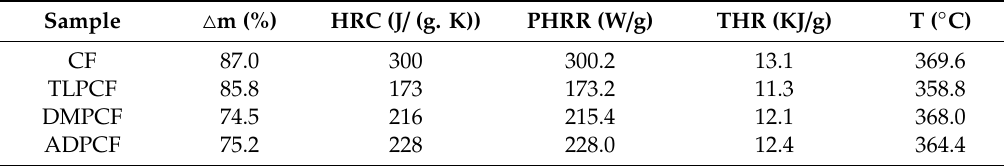
Table 2. Microscale combustion properties of control and modified cotton fabrics.